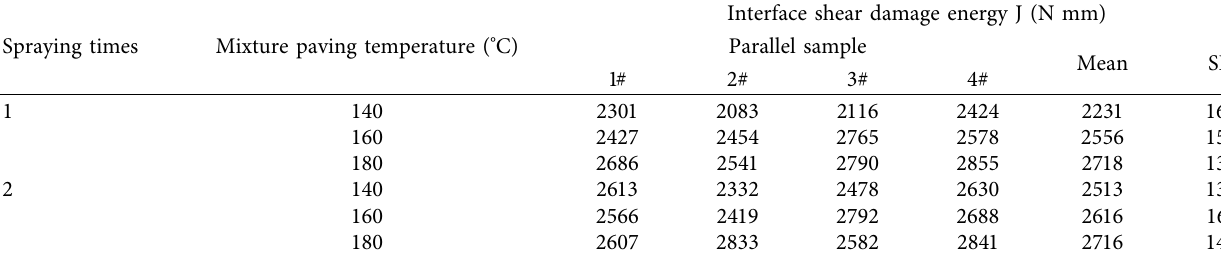
Table 5: Test results for distinct paving technology of geotextile